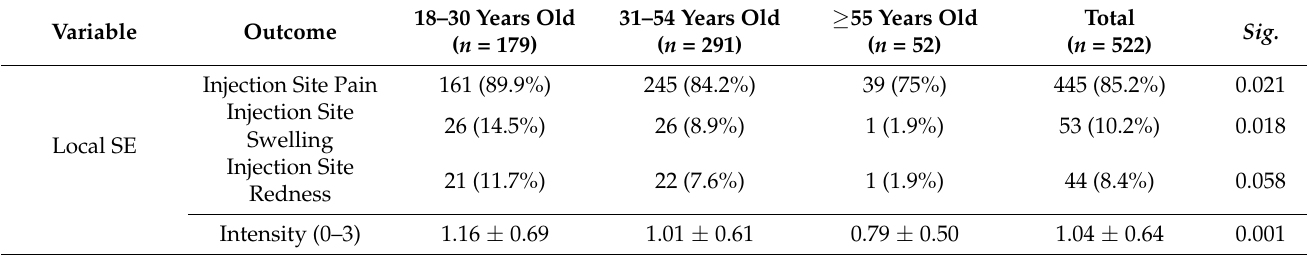
Table 5. Local and systemic side effects of Slovak healthcare workers who received BNT162b2 and stratified by age group, February–March 2021 ( n =